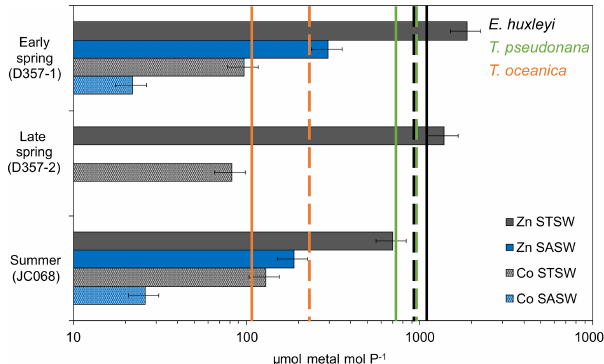
Figure 6. Metal / PO 3 − inventory ratios for the upper water col- 4 umn of the south-eastern Atlantic (horizontal bars) compared with laboratory estimates of cellular ratios in eukaryotic phytoplankton below which growth limitation occurs (solid vertical lines repre- sent Zn / P with no added Co to media, whilst dashed lines rep- resent Co / P with no added Zn; phytoplankton data from Sunda and Hunstman, 1995). Error bars on inventory ratios represent 20% combined uncertainty for dZn and dCo analyses (see Sect. 2.2). This figure is adapted from that in Saito et al. (2010) and implies that inter-seasonal differences in metal:PO 3 − stoichiometry could 4 impact phytoplankton community composition in the south-eastern